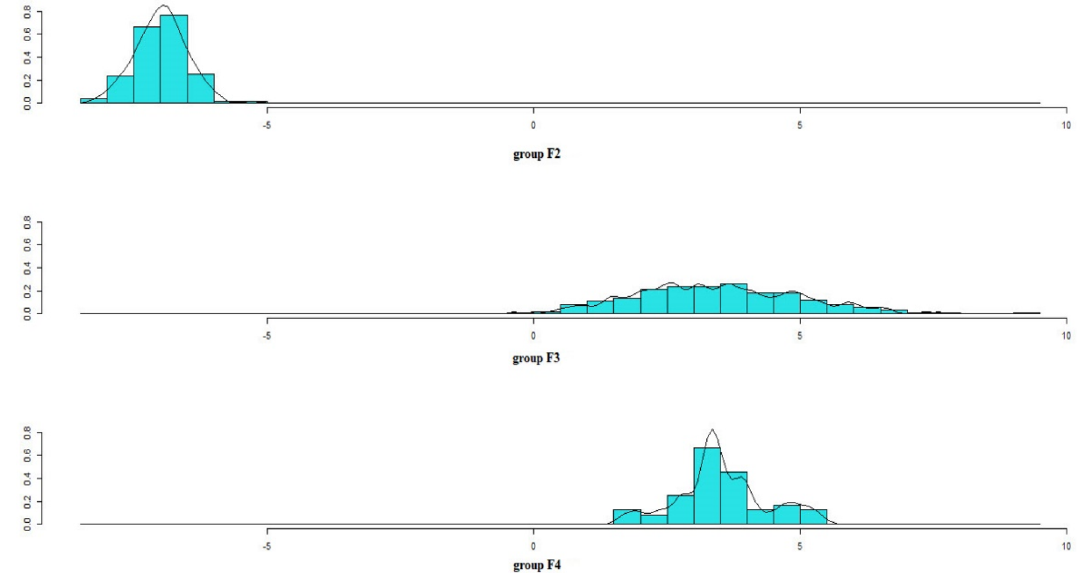
Figure 2. Stacked histogram for discriminant function values based on LD1.